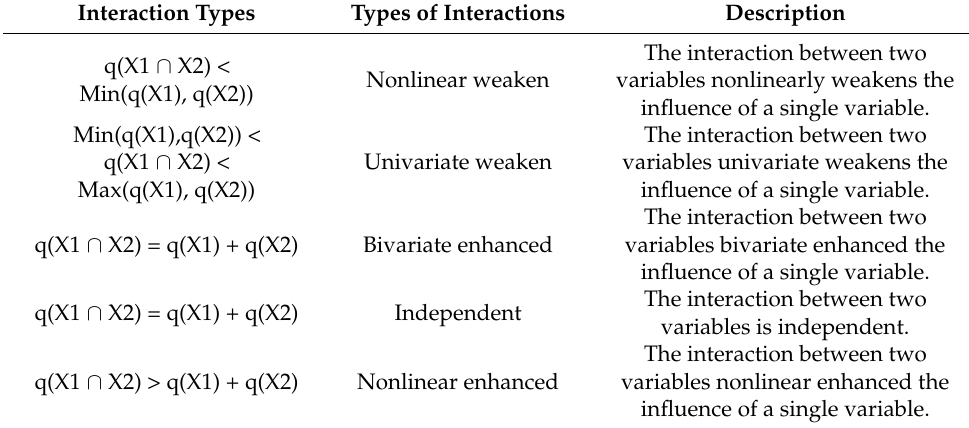
Table 2. Definitions of interaction